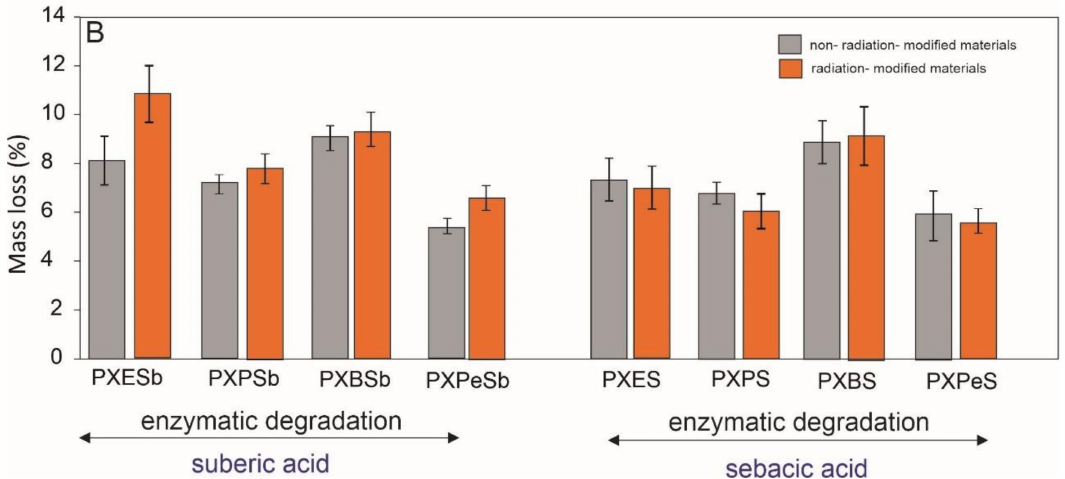
Figure 14. Hydrolytic ( A ) and enzymatic degradation ( B ) of PXESb, PXPSb, PXBSb, PXPeSb and PXES, PXPS, PXBS, PXPeS non-radiation-modified materials (gray) and radiation-modified materials (orange).